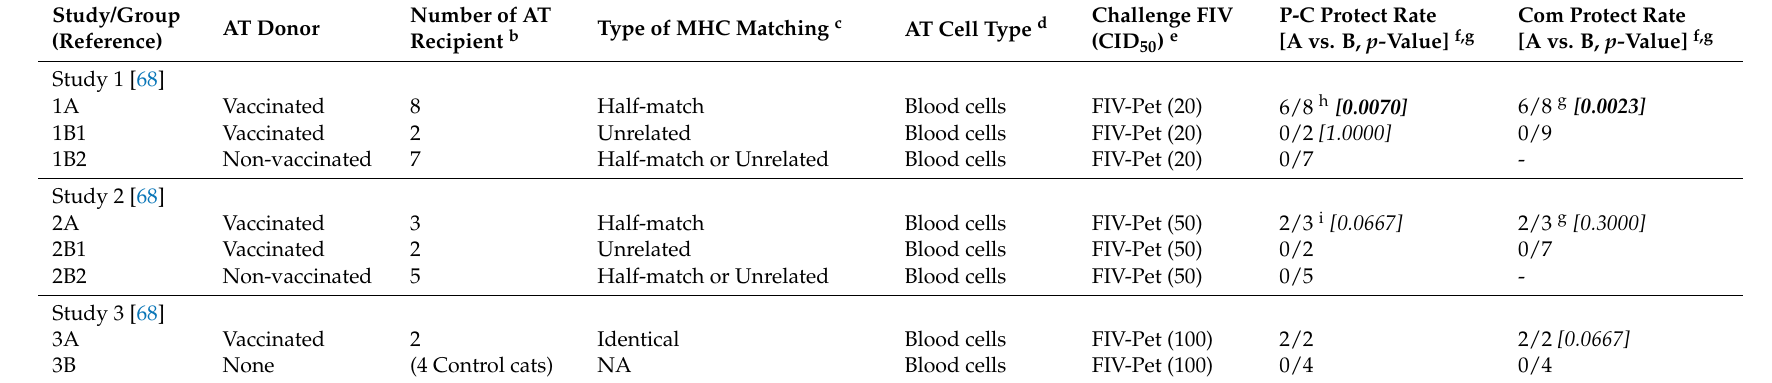
Table 6. Adoptive transfer (AT) Studies to test the role of immune T cells from prototype IWV-vaccinated cats